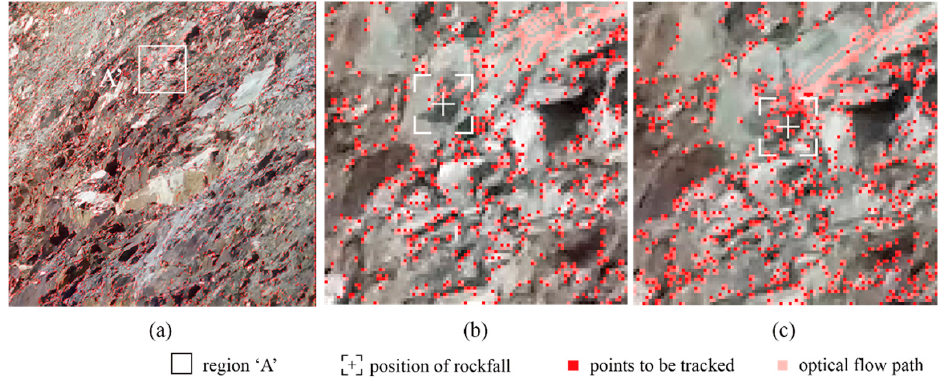
Figure 10. Results of sparse optical flow analysis using Lucas–Kanade method: ( a ) points generated (red spots) by Shi–Tomasi corner detection method in the cropped slope area used for optical flow; ( b ) enlarged picture of optical flow lines and the position of tracked rock for test #4 in the region ‘A’; ( c ) for test #5.